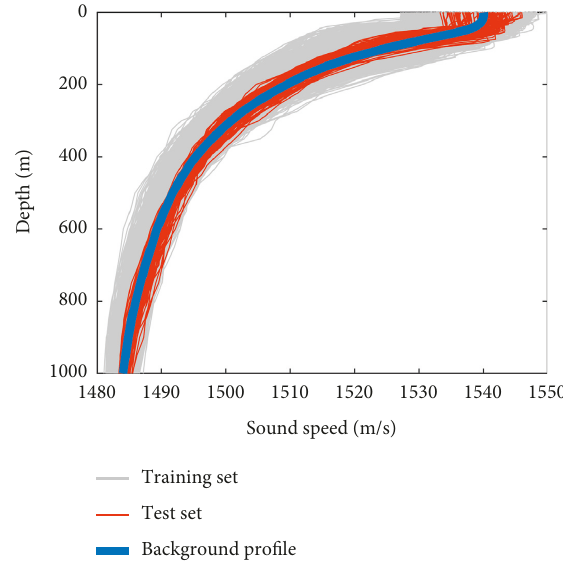
Figure 3: Training, test, and background profiles.